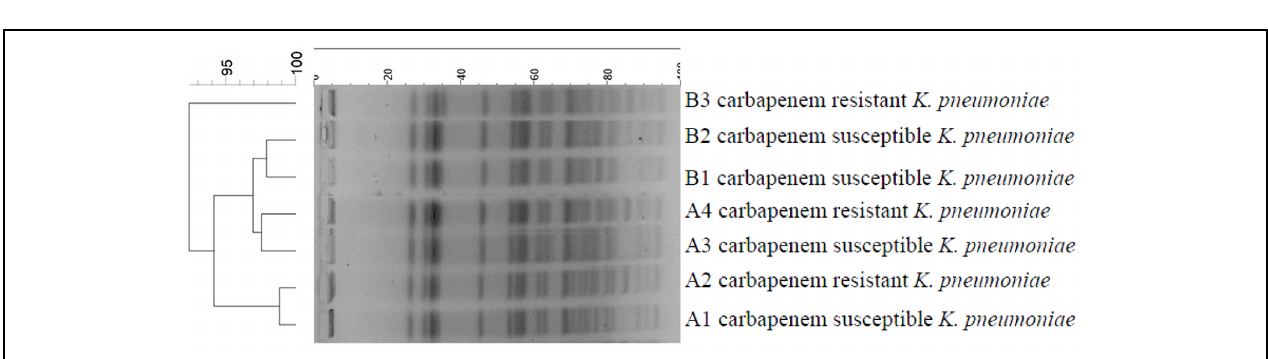
FIGURE 2 | DNA fingerprinting of K. pneumoniae strains by PFGE. A1, A2, A3, and A4 isolated from twin A (old brother); B1, B2, and B3 isolated from twin B (young